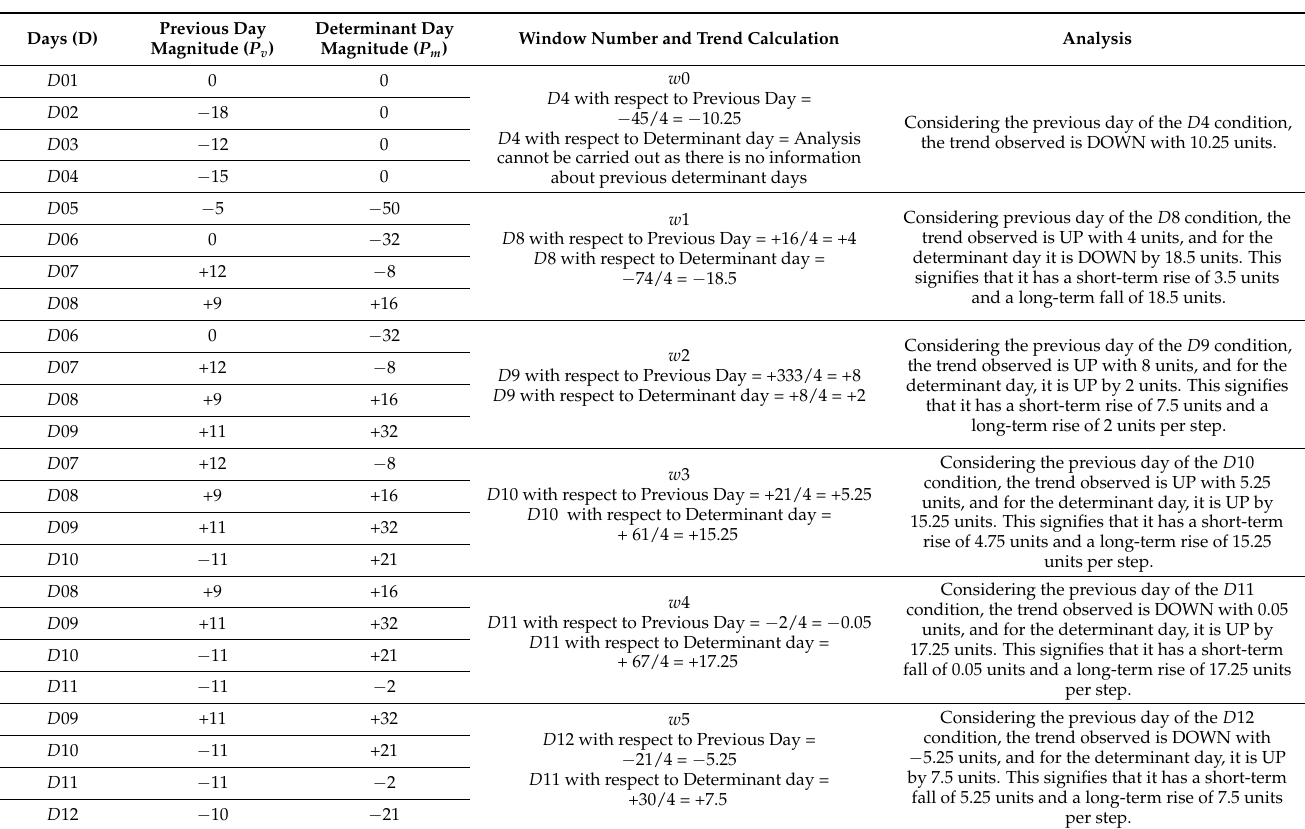
Figure 1. Example of proposed trend analysis strategy showing lows and highs for determining the up trends and down trends. Table 1. Example of proposed trend analysis strategy.